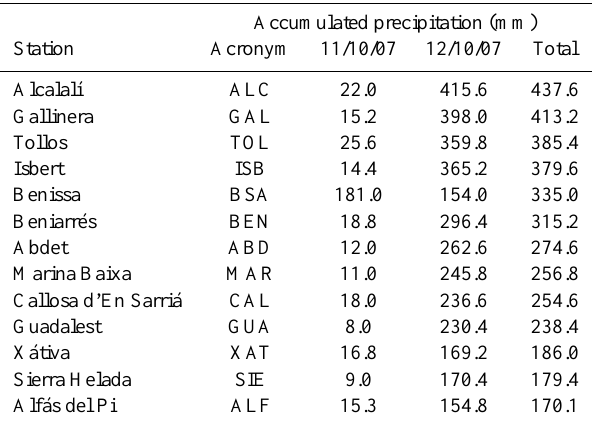
Table 1. Accumulated precipitation (mm) during 11–12 October